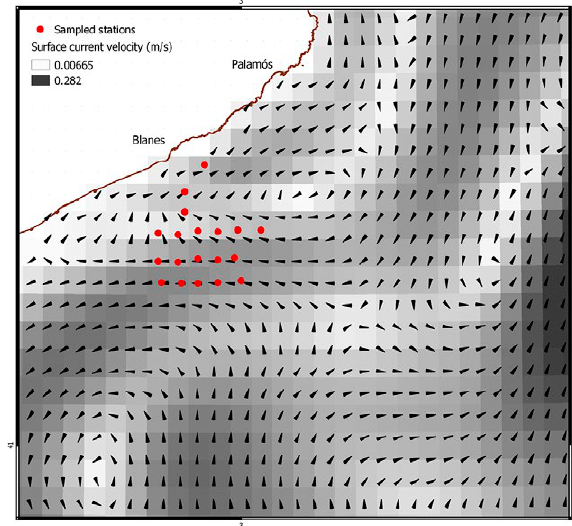
Fig. 8. – Average surface current velocity from reanalysis (http://marine.copernicus.eu/) during the month of September 2011. Red dots represent the sampled stations. Black arrows represent the direction of the